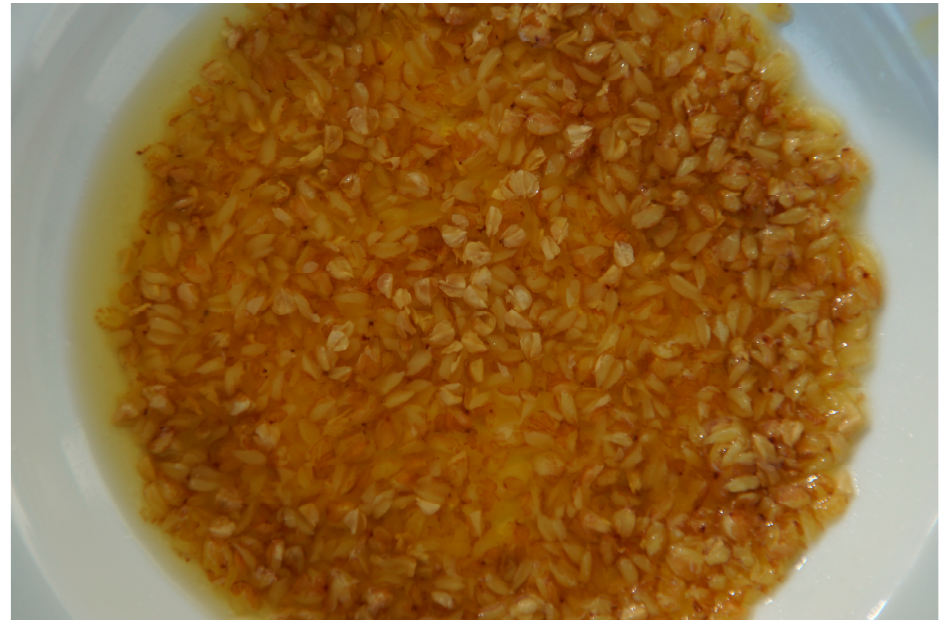
Figure 4. One of the simplest dishes with Tartary buckwheat kasha is Tartary buckwheat soup. About 10 percent (volume) Tartary buckwheat kasha is added to very lightly salted 10 percent (volume) Tartary buckwheat kasha is added to very lightly salted water, boiled for few water, boiled for few minutes, and a few spoons of spicy olive oil are added. minutes, and a few spoons of spicy olive oil are